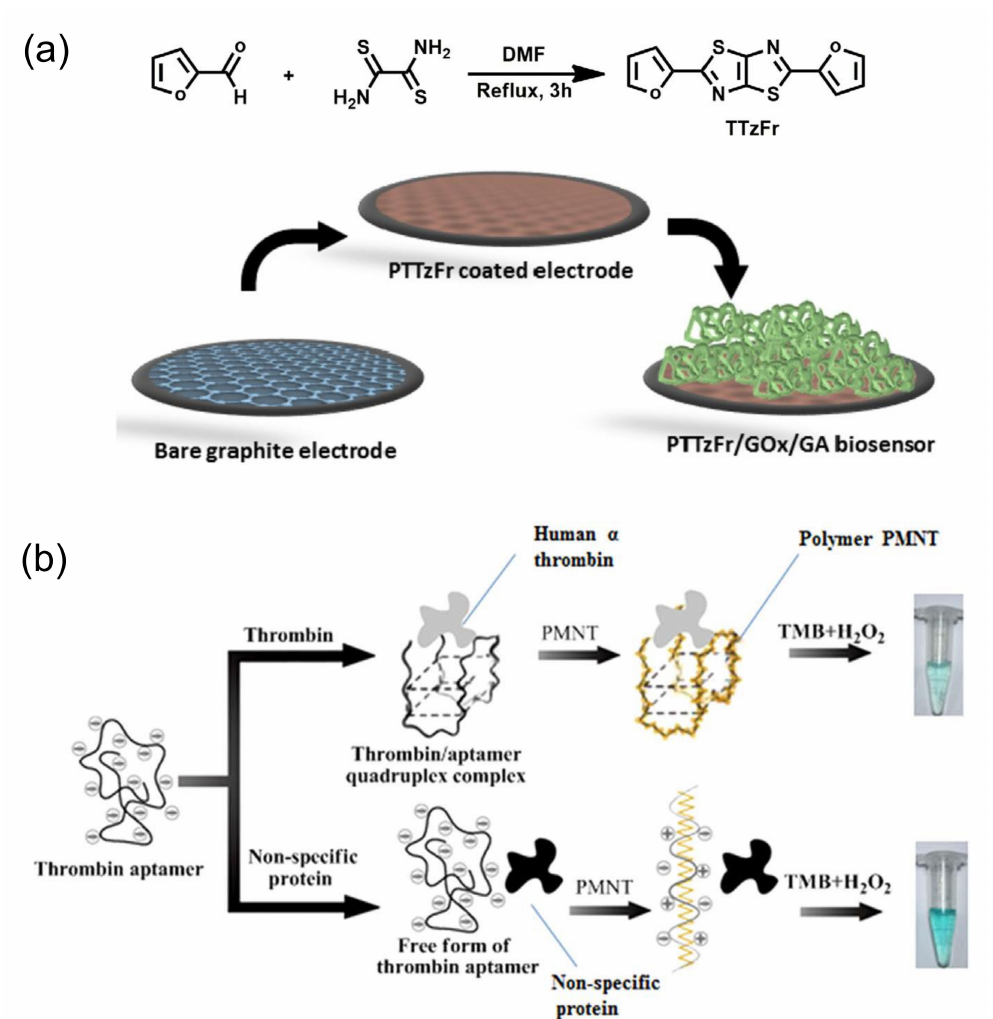
Figure11. ( a )ThePTTzFrfilm-basedelectrochemicalsensorsforglucosedetection[134]. Copyright2019, Elsevier. ( b ) The poly [3-(3 (cid:48) - N , N , N -triethylamino-1 (cid:48) -propyloxy)-4-methyl-2,5-thiophene